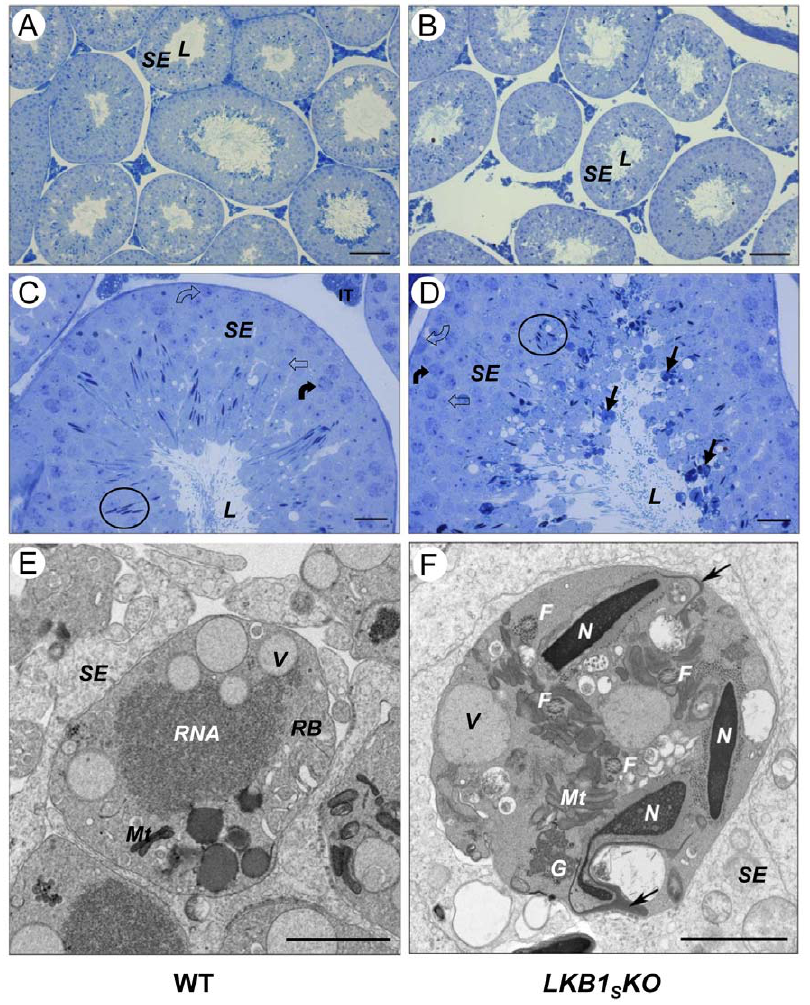
Figure 4. Testis histology. Cross-sections of seminiferous tubules from wild-type (left-hand panel, A and C ) and LKB1 S KO (right-hand panel, B and D ) mice. The seminiferous epithelium ( SE ), which is made up of sertoli cells and developing germ cells, is indicated. This surrounds the lumen ( L ) of the tubules. ( C ) and ( D ) show sections from tubules at approximately stage V. Circles have been used to show the nuclei of elongating spermatids. Spermatogonia ( open curved arrow ), spermatocytes ( closed curved arrow ) and round spermatids ( open arrow ) are also indicated. A number of dense, round bodies of varying sizes can be seen around the lumens from LKB1 S KO mice. Examples of these are indicated in ( D ) ( closed black arrows ). Representative images are shown (A and B, scale bar =100 m m; C and D, scale bar =20 m m). ( E ) and ( F ) show TEM images of a residual body (RB) within the seminiferous epithelium (SE) from a wild-type mouse ( E ), and an abnormal cytoplasmic body from a LKB1 S KO mouse ( F ). Normal residual often contain such structures as vacuoles ( V ), RNA and mitochondria ( Mt ). The abnormal cytoplasmic bodies seen in ( F ) are similar to residual bodies but often contain at least one condensed spermatid nuclei (N) and several cross sections of flagella (F) as indicated. Detached acrosomes, identified as the deeply staining crescent shape structures close to the anterior nuclear surface, are indicated with an arrow. Granular material is also indicated (G) , (E and F, scale bar =2 m m).